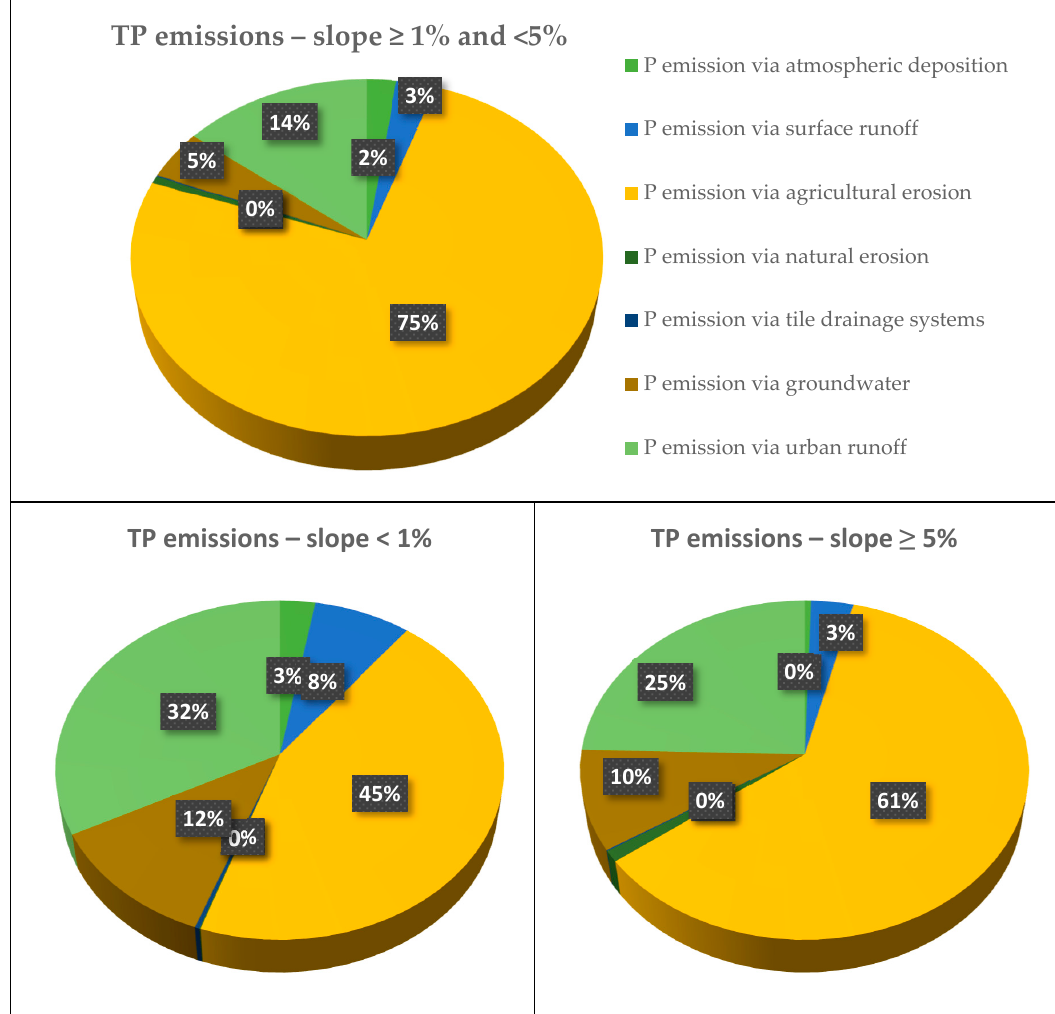
Figure 13. Division of total diffuse-source TP emissions per pathway and slope class.